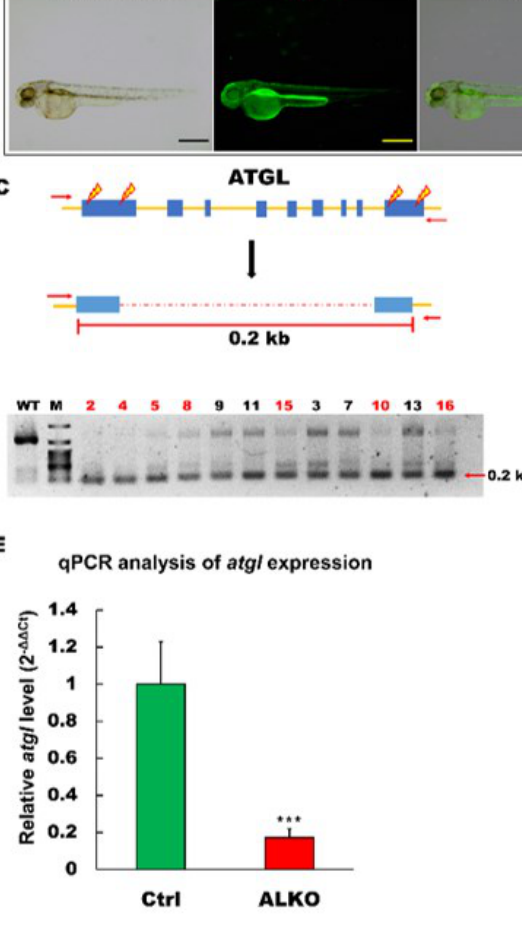
Figure 1. Generation of zebrafish ALKO mutant using CRIPRC-Cas9 system. ( A ) Schematics of the structure of β -Act-2A-Cas9-GFP expression vector. The transcriptional activity of Cas9 elements (sky blue) was driven by β -actin 2.5k promoter (yellow). The lower panel shows the fluorescence pattern of Tg ( β -Act-2A-Cas9-GFP ) with a global expression of GFP at 2 days post-fertilization (dpf). Scale bar: 500 μm. ( B ) Schematics of the structure of Cmlc2-GFP-U6-gRNA atgl -4X expression vector. The GFP expression represented the success of transgenesis of Tg ( Cmlc2-GFP-U6-gRNA atgl -4X) at 5 dpf. Scale bar: 600 μm. ( C ) Upper: Schematic diagram of the outer primers of atgl loci used for PCR detection of mutations. The outer primers are to the mutated site/scheme of the locations of PCR primers (red arrows) designed to detect a disruption in the spacer between the first exon and the last one. Yellow lightening symbols denote the site of four selective gRNAs; navy blue boxes denote all of the exons in the atgl loci; red dashed line denotes the spacer; red line denotes the length between external primers without the spacer. Lower: Result of semi-qRT – PCR analyses on the whole embryo of transient F0 fish containing the corresponding mutations (as indicated in the upper panel of C). ( D ) Whole-mount in situ hybridization showing the reduction of atgl in ALKO mutant larvae at 120 hpf. Scale bars = 80 μ m. ( E ) Quantitative of atgl expression by RT-qPCR analysis at 7 dpf. Heterozygous ALKO mutants were generated by cross-homozygous Tg ( β -Act-2A-Cas9-GFP ) and Tg ( Cmlc2-GFP-U6-gRNA atgl -4X). Control: Heterozygous Tg ( Cmlc2-GFP-U6-gRNA atgl -4X) . *** ( p < 0.001) indicates statistically significant differences from the controls. Value of atgl in ALKO = 0.1721 ± 0.0421.